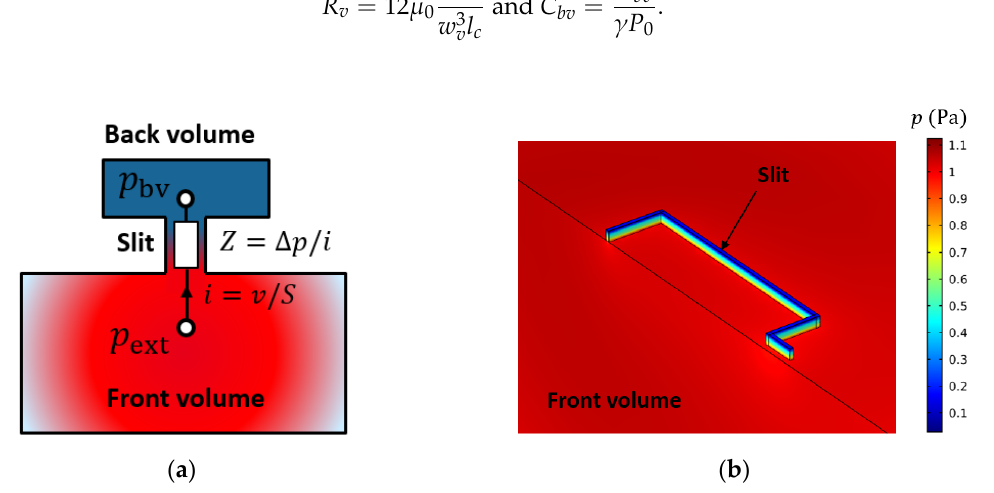
Figure 6. ( a ) Sectional schematic of the slit problem; ( b ) Pressure behavior inside the slit and the front volume for a slit length of 100 µ m with p ext = 1 Pa. (the mechanical structure and the back volume are not shown for the sake of clarity).